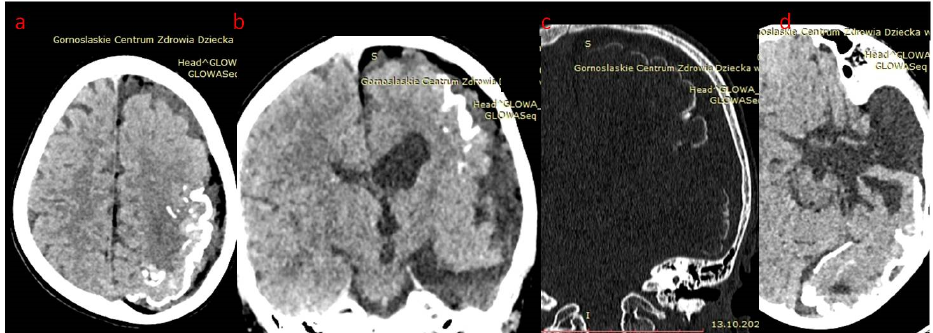
Figure 1. ( a – d ) Patient 1. Head CT brain window: ( a ) axial and ( b ) reformatted coronal plane; hemiatrophy of left hemisphere, left ventriculomegaly, meningeal lipomatosis, arachnoid cyst in temporal fossa and gyral calcifications; ( c ) bone window coronal reformatted plane: extensive left sided gyral calcifications; ( d ) axial plain—left arachnoid cyst.